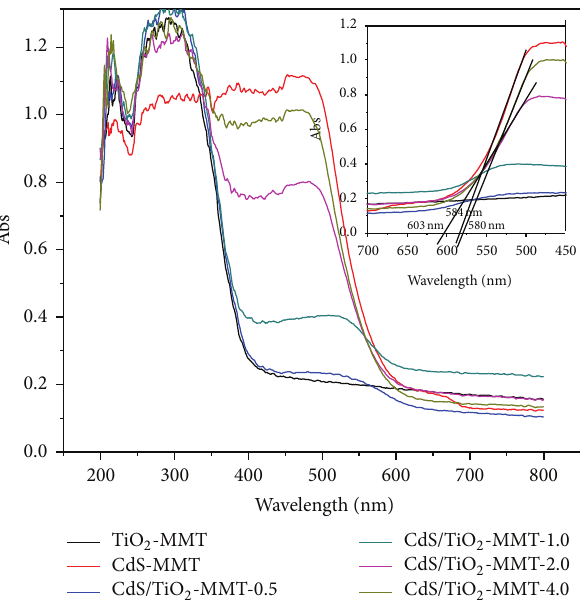
Figure 6: Ultraviolet visible-light absorption ability of CdS/TiO 2 -